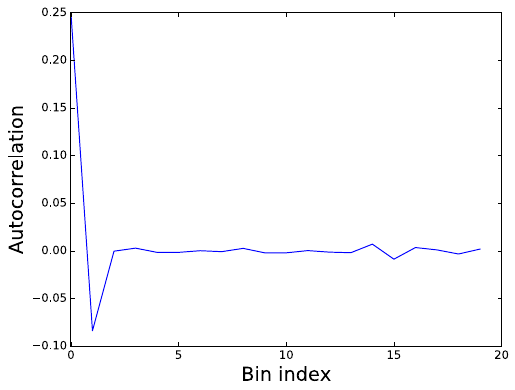
Fig. 4. Autocorrelation function of the random sequence.